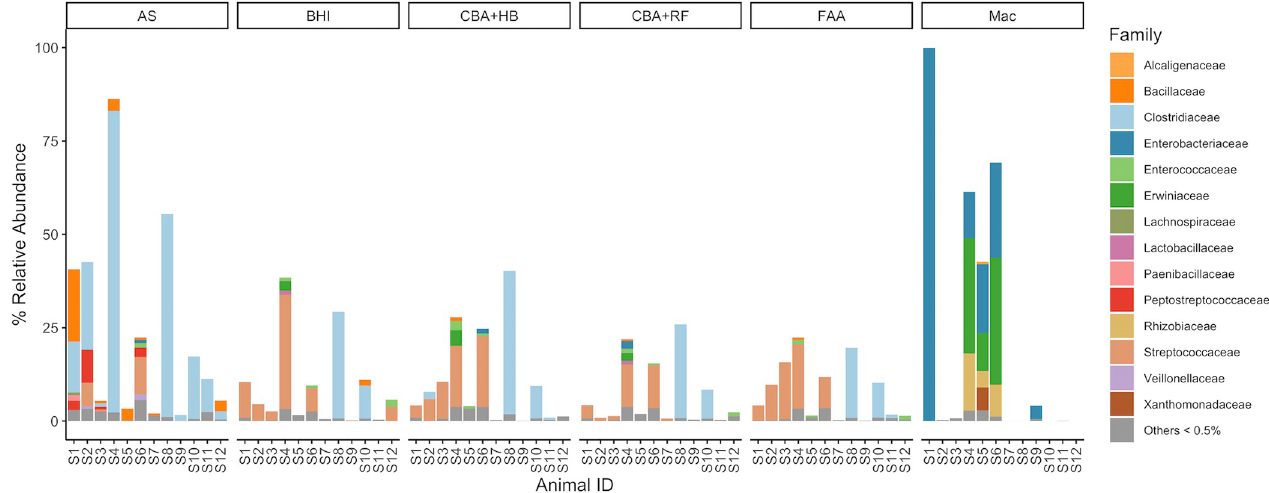
Fig 6. Relative abundance of ASVs in culture-derived samples. Only ASVs that were present in at least one culture-derived sample but absent in all cecum samples are included. Relative abundances were partitioned by culture media and individual animal ID. ASVs were grouped at family taxonomy. Families with relative abundances less than 0.5% were grouped together. Abbreviations: MacConkey agar (Mac), fastidious agar with horse’s blood added (FAA), Columbia agar with horse’s blood added (CBA+HB), Columbia agar with rumen fluid added (CBA+RF), BHI3 with carbohydrate added (BHI), and AS (samples plated on CBA+HB after alcohol shock). Healthy horses: S1-S6. Acute typhlocolitis horses: S7-S12.